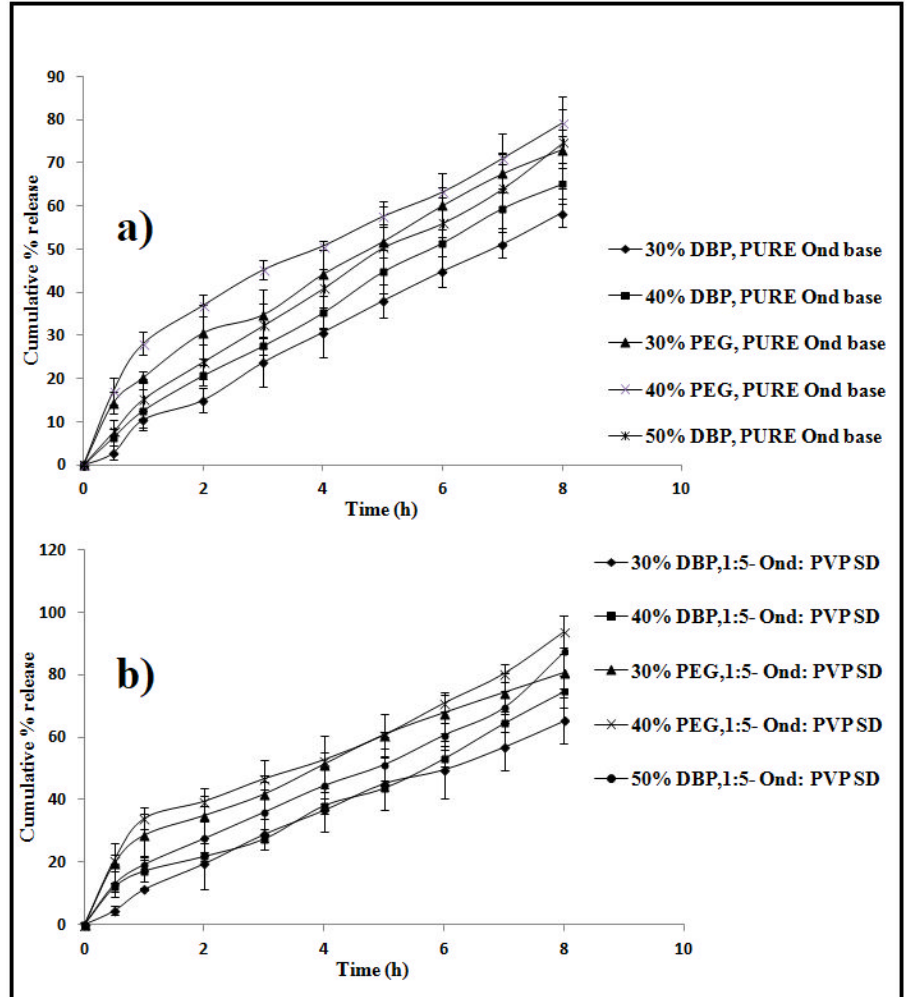
FIGURE 3 - In-vitro diffusion profile of a) Pure OND loaded patches b) SD loaded